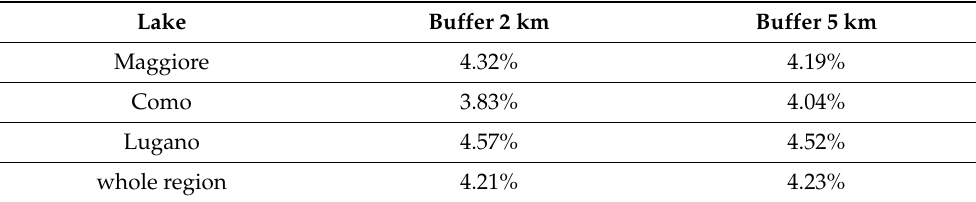
Table 2. Facebook data representativeness for the study areas, expressed as the ratio [%] between the mean night-time Facebook users’ count during the low tourism seasons and actual resident population retrieved from the WorldPop dataset